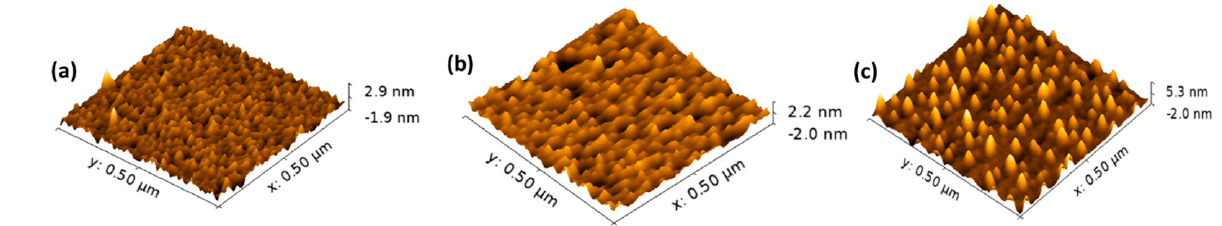
Figure 4. 3D AFM images of the fabricated samples ( a ) NH-116 ( b ) NH-117 and ( c ) NH-121.